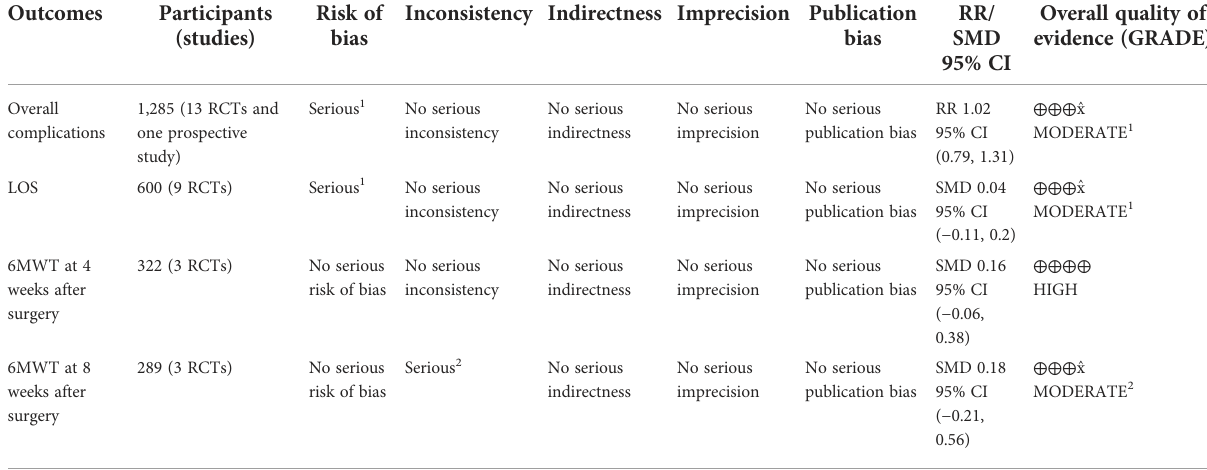
TABLE 2 Summary of fi